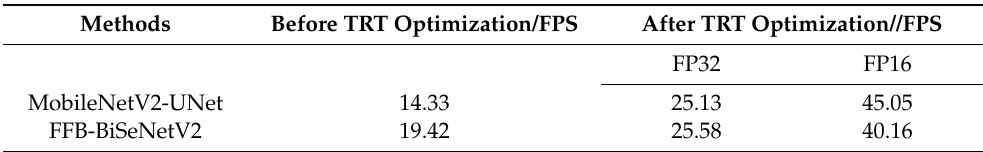
Table 3. Real-time comparison of the improved semantic segmentation model before and after optimization.